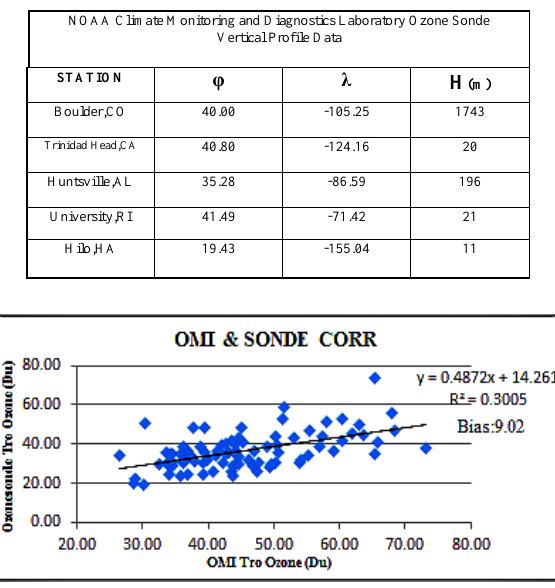
Table 1 - Features of stations measuring ozone ESRL network